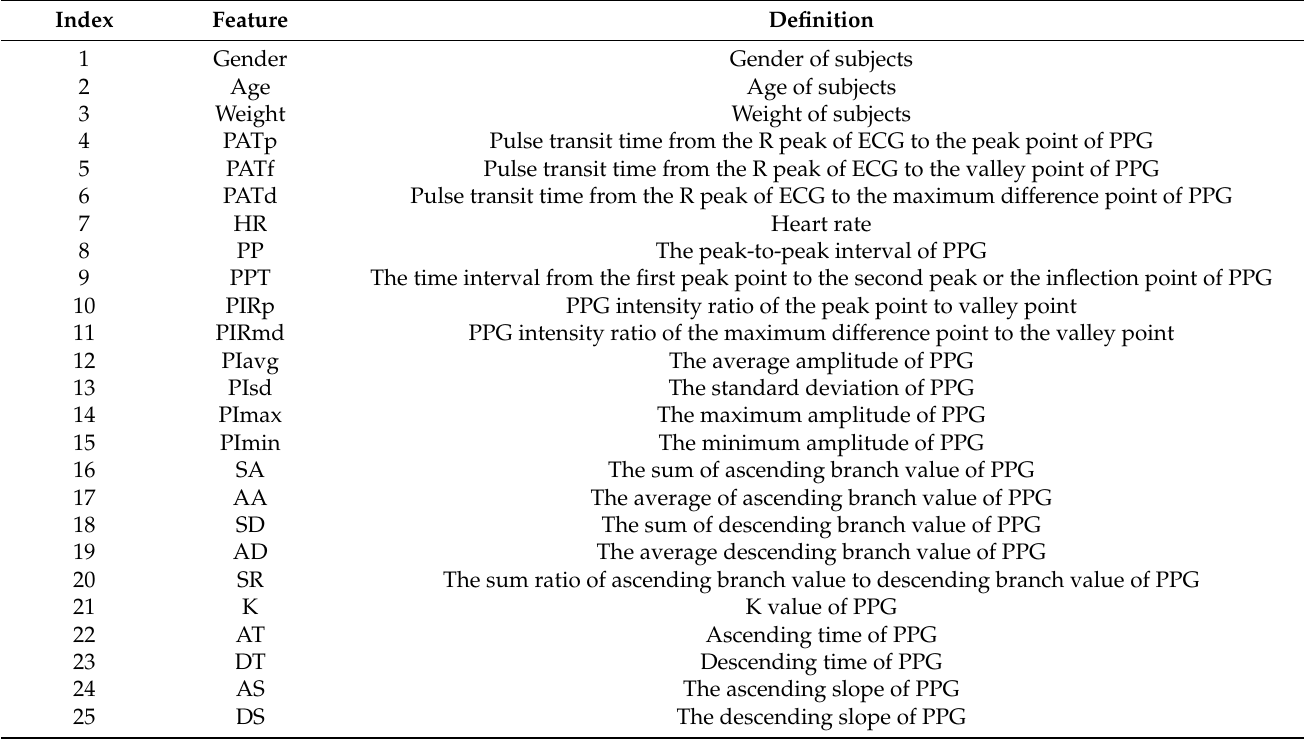
Table 1. Feature abbreviation and